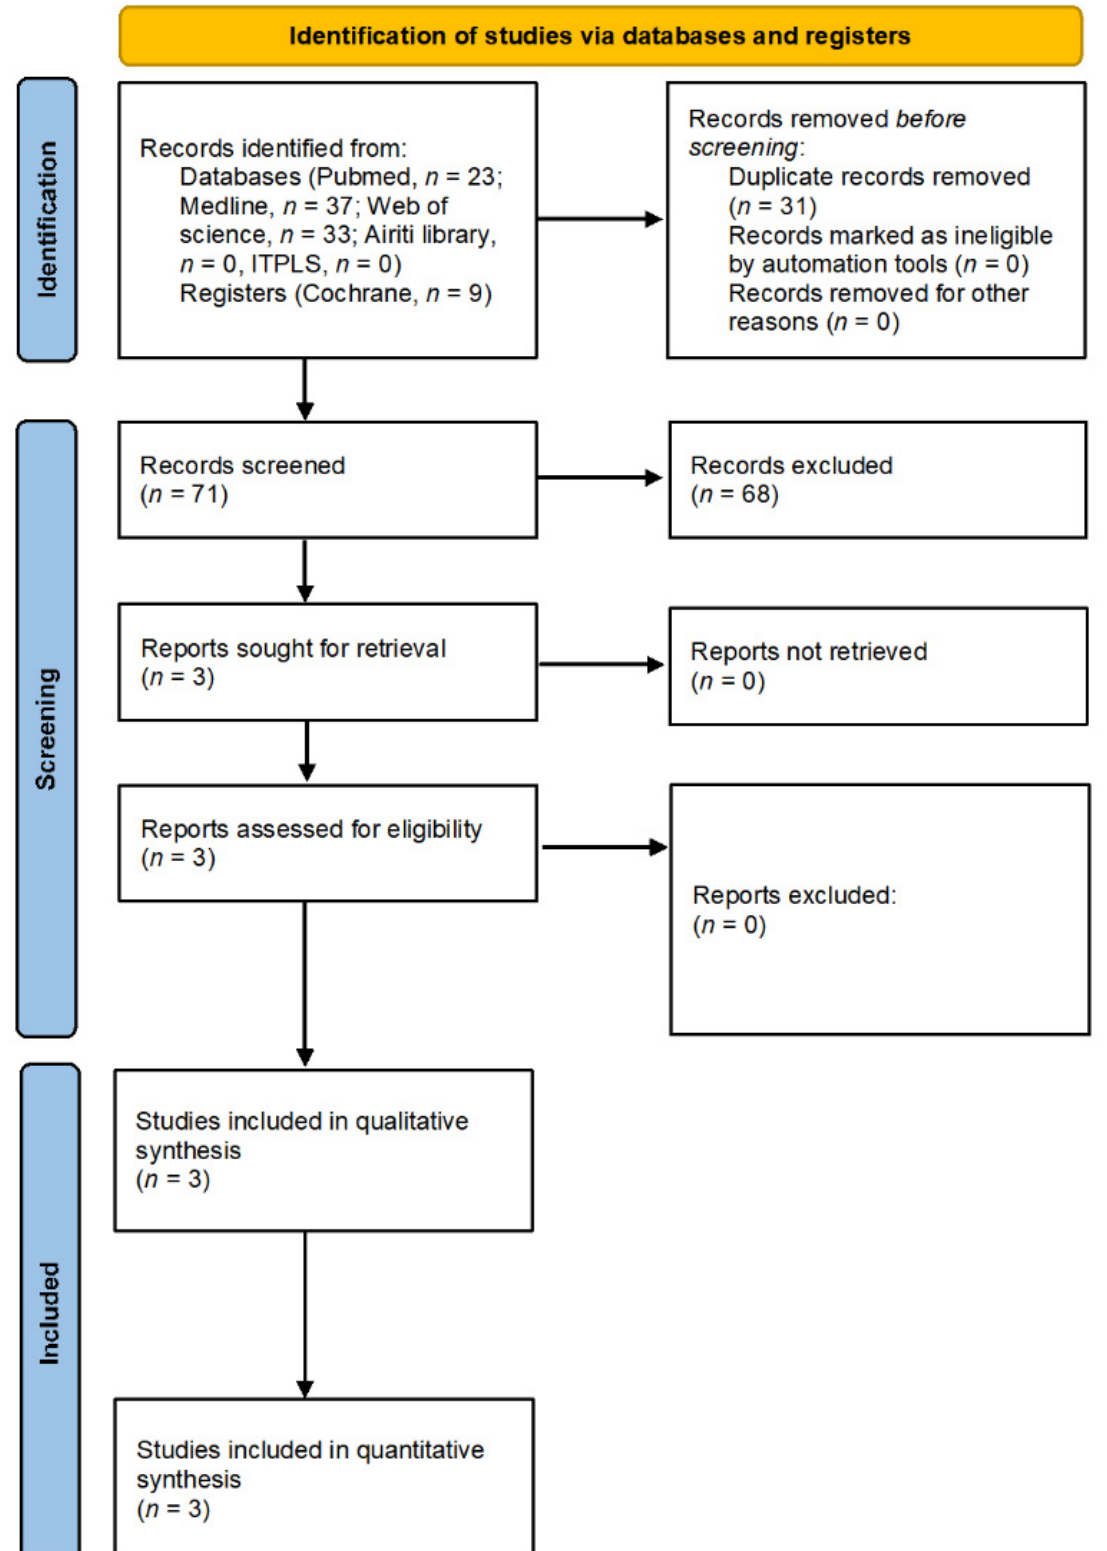
Figure 1. Literature screening process and results.